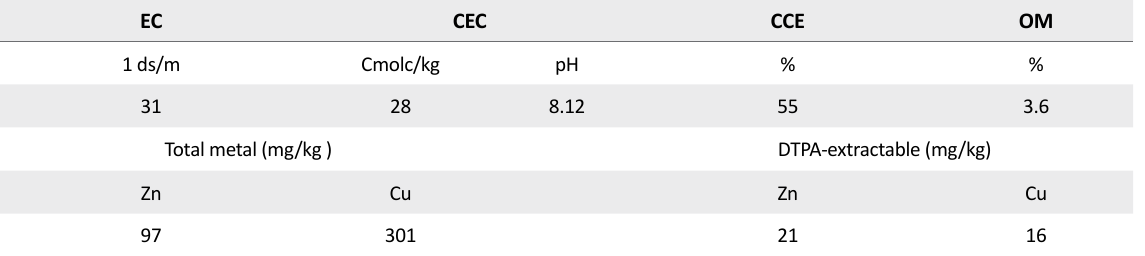
Table 2. Some physicochemical characteristics of the experimental drilling cutting EC CEC CCE OM 1 ds/m Cmolc/kg